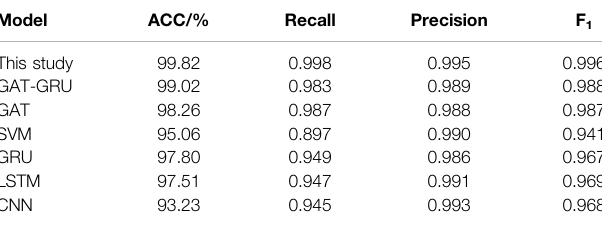
TABLE 2 | Model performance comparison.